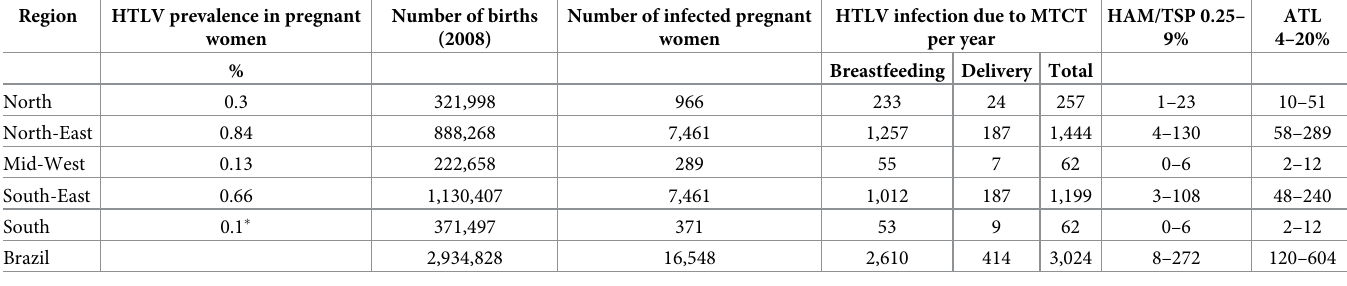
Table 3. Estimated number of HTLV-1 infection, HAM/TSP and ATL cases due vertical transmission per year in Brazil and its regions. Region HTLV prevalence in pregnant women